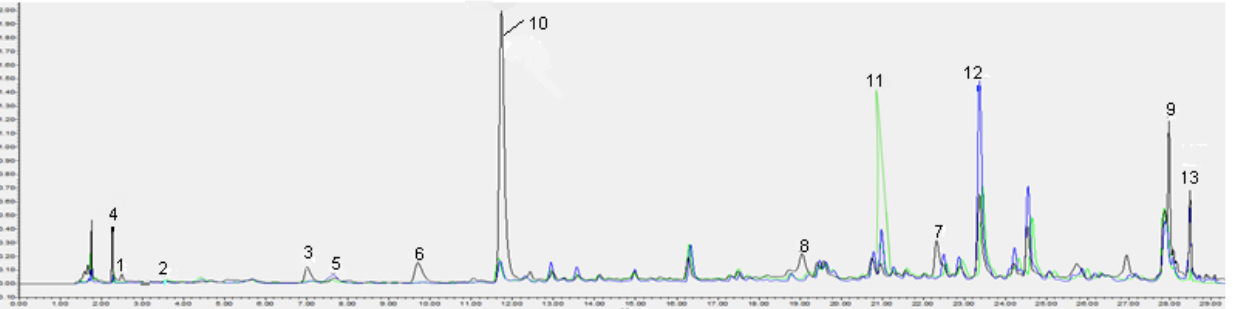
Figure 1. Comparison of phenolic acid (1—protocatechuic, 2—pyroglutamic, 3—pyruvic, 4—gallic, 5—2.5-dihydroxybenzoic, 6—4-hydroxybenzoic, 7—caffeic, 8—syringic, 9— p -coumaric, 10—ferulic, 11—chlorogenic, 12—sinapic, 13—t-cinnamic) UPLC chromatograms: Ps (green line), Km (black line), Io (blue line).